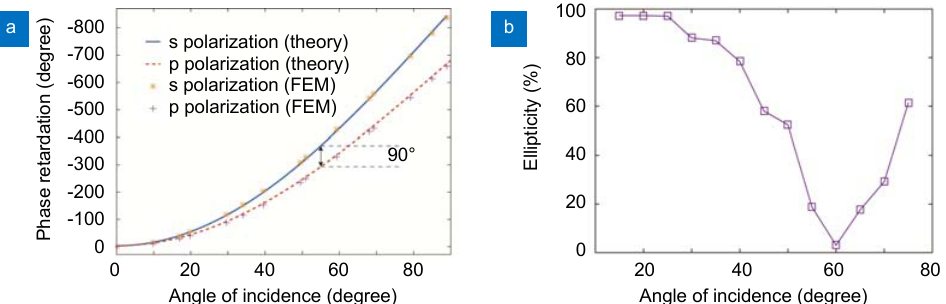
Fig. 4 | Metallic posts array acting as a reflective waveplate. ( a ) Reflective phase retardation at different incidence angles for s - and p - polarizations at λ =10.6 μ m. The distance between the reference plane and the top of the posts array is 10 μ m. The theory is based on the effective impedance and transfer matrix method. ( b ) Measured ellipticity of the reflected laser beam generated by a CO 2 laser ( λ = 10.6 μ